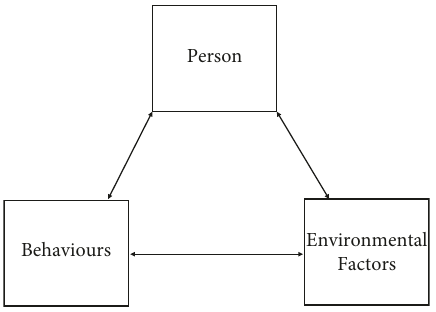
Figure 1: Social cognitive theory